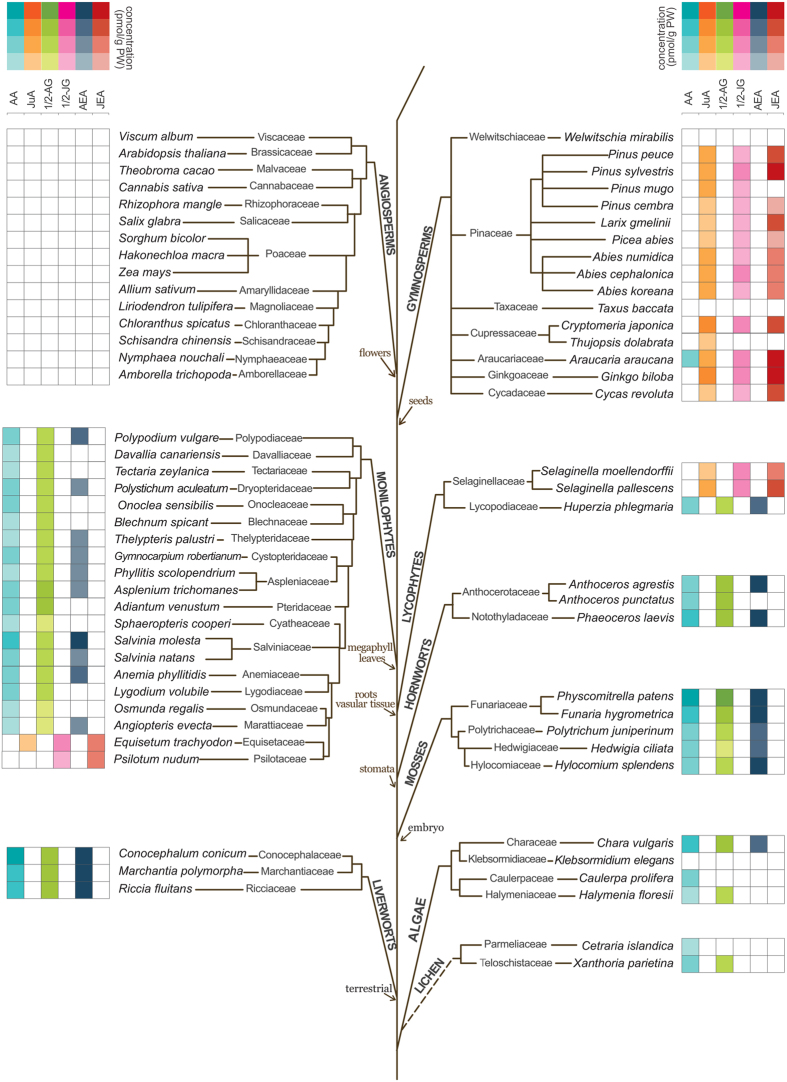
Chemotaxonomic distribution of C-20 PUFA metabolites.AA (pale blue), JuA (orange), 1/2-AG (green), 1/2-JG (pink), AEA (blue) and JEA (red). The intensity of the colors indicates concentration. The concentration ranges used for AA and JuA are 54 to 1E4 (shade 1), 1E4 to 1E5 (shade 2), 1E5 to 1E6 (shade 3) and >1E6 (shade 4); for 1/2-AG and 1/2-JG are 37 to 1E3 (shade 1), 1E3 to 1E4 (shade 2), 1E4 to 1E5 (shade 3) and >1E5 (shade 4); and for AEA and JEA are 0.8 to 1 (shade 1), 1 to 10 (shade 2), 10 to 100 (shade 3) and 100–1000 (shade 4).